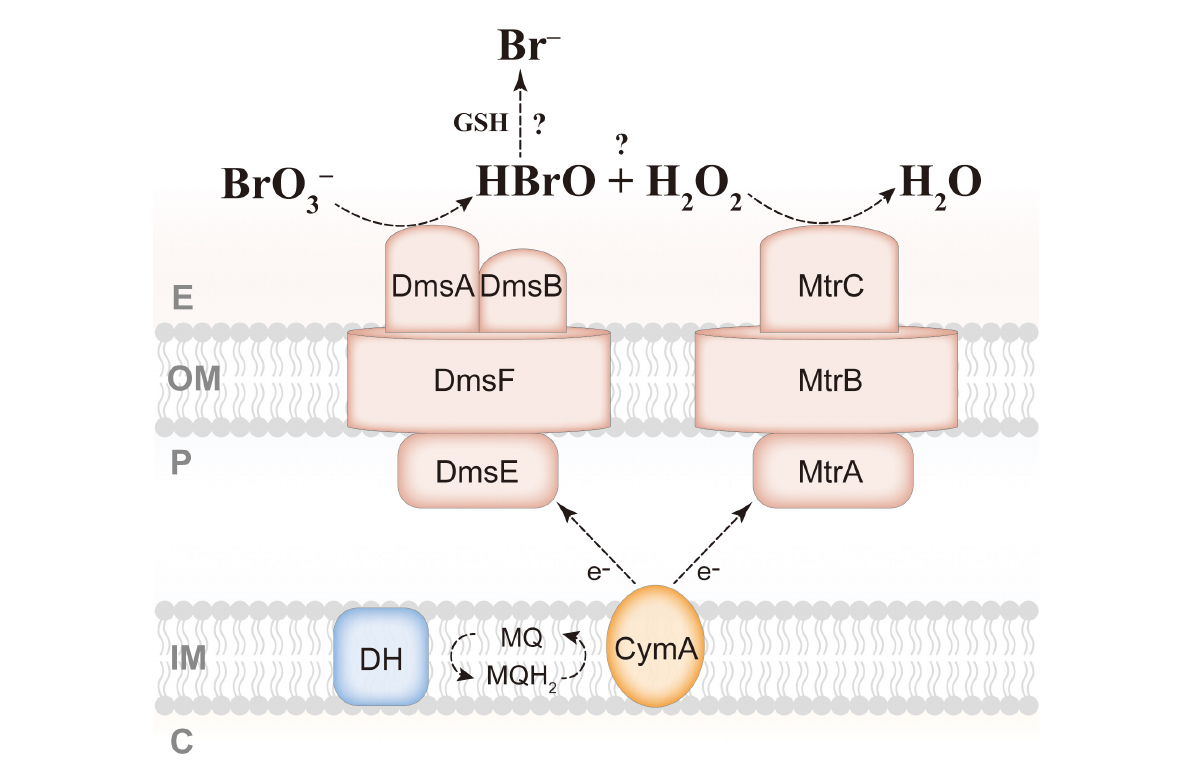
FIGURE5 Proposed mechanism for extracellular reduction of bromate by S. oneidensis MR-1. GSH, reduced glutathione; E, extracellular space; OM, outer membrane; P, periplasm; IM, inner membrane; C, cytoplasm; DH, dehydrogenase; MQ,